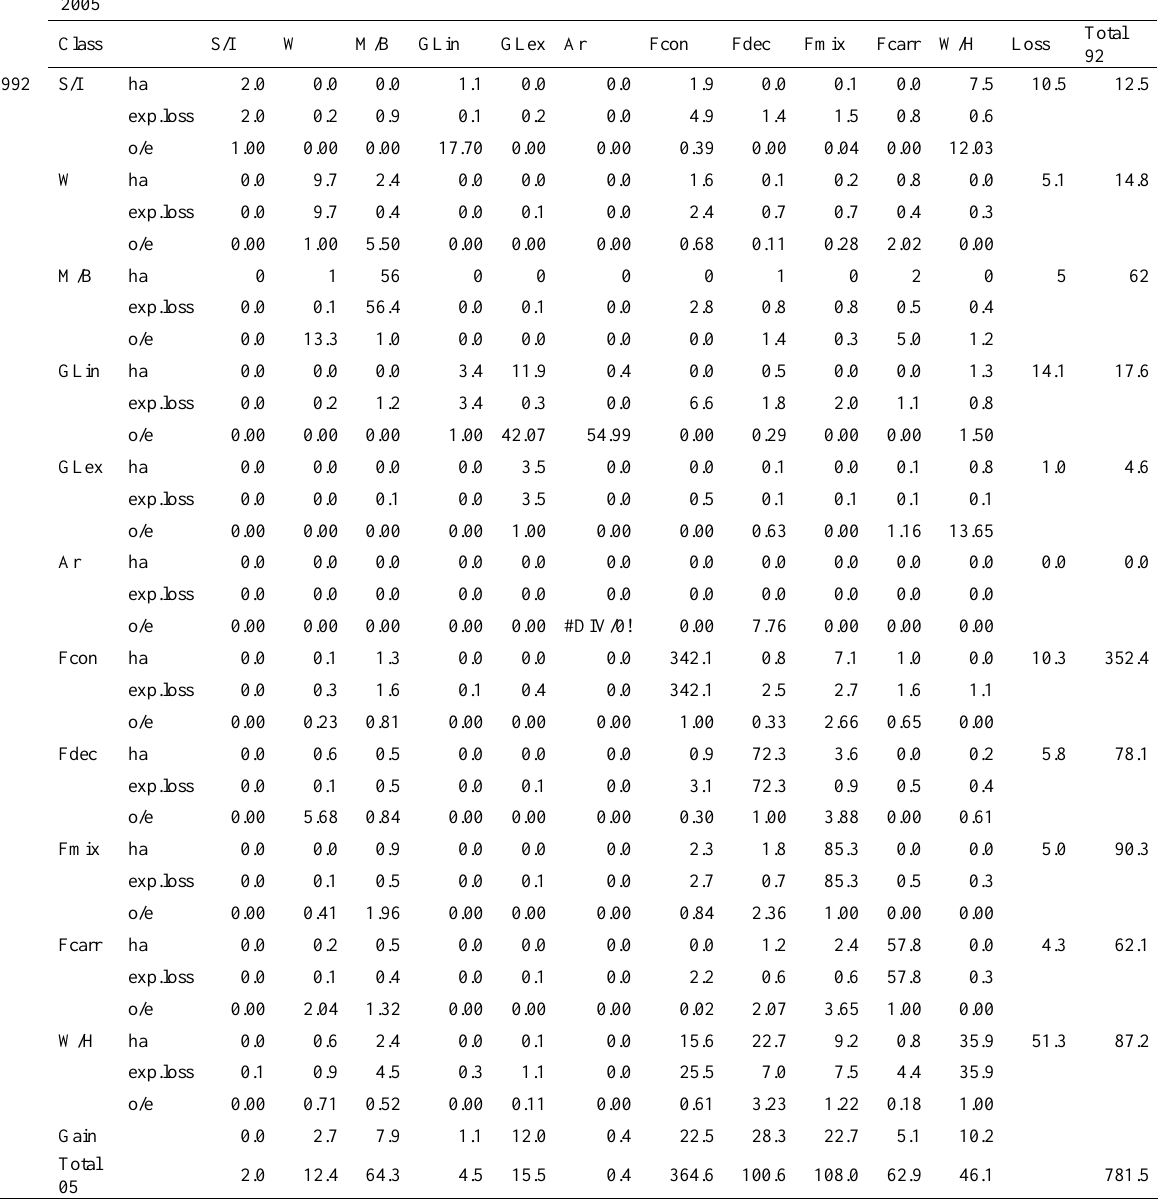
Table A1.3: Core